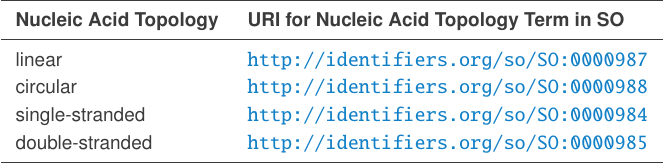
Table 3: Sequence Ontology (SO) terms to encode DNA or RNA topology information in the type properties of a Component